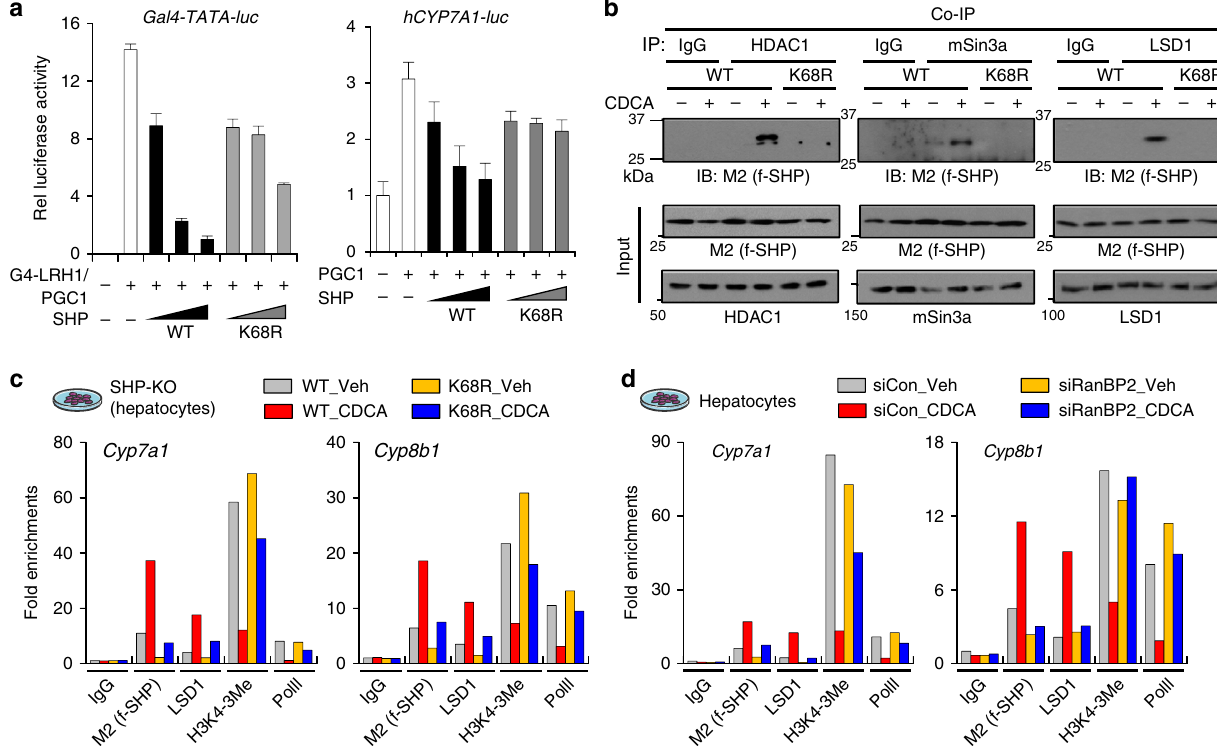
Figure 4 | SUMOylation at K68 increases SHP-mediated epigenetic repression of BA synthetic genes. ( a ) Luciferase reporter assay: HepG2 cells were transfected with plasmids as indicated and luciferase activities were normalized to b -galactosidase activity ( n ¼ 3). ( b ) CoIP: Flag-SHP WT or the K68R mutant was expressed in HepG2 cells and then, the cells were treated with 50 m M CDCA for 30min. LSD1, HDAC1 or mSin3A was immunoprecipitated with their respective antibodies and flag-SHP in the immunoprecipitates was detected by M2 antibody. ( c , d ) ChIP: ( c ) Ad-flag-SHP or the K68R mutant were expressed in SHP-KO primary mouse hepatocytes or ( d ) endogenous RanBP2 was downregulated by siRNA in normal mouse hepatocytes and then, cells were treated with vehicle or 50 m M CDCA for 1h. Chromatin was isolated and precipitated with IgG or antibody as indicated and the enrichment of DNA sequence for Cyp7a1 or Cyp8b1 was determined.